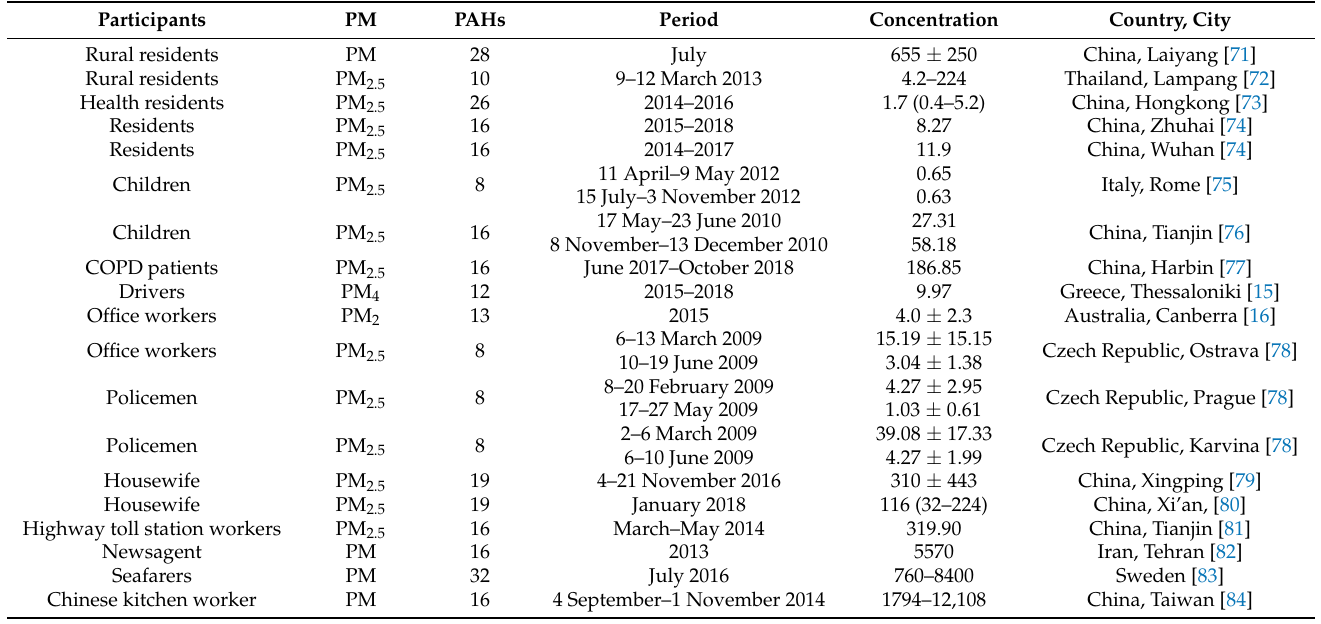
Table 4. Personal exposure concentration (average and/or range, ng/m 3 ) of PM-bound PAHs in several